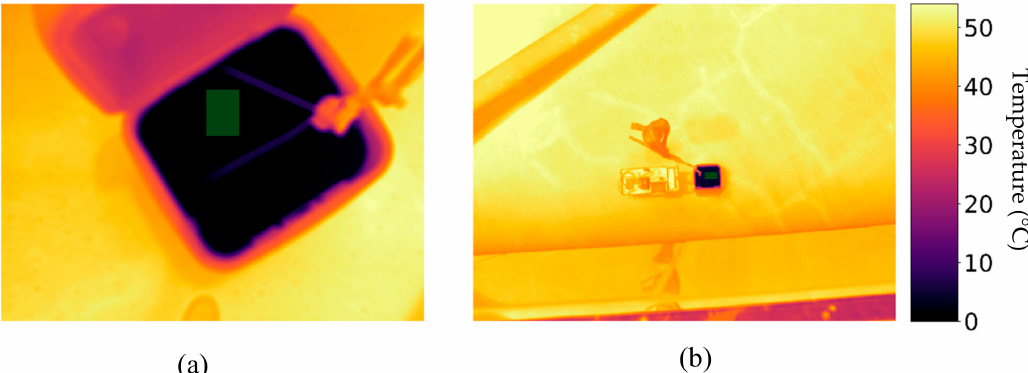
Figure 11. ( a ) Temperature map of a cooler filled with ice taken at a distance of ~40 cm with an ambient temperature of 37 ◦ C. The average value of the ice pixels inside the cooler (represented by the green rectangle) was –0.105 ◦ C. ( b ) Temperature map of same ice filled cooler taken at a distance of ~10m. The average value of ice only pixels (green rectangle) was 4.064 ◦ C illustrating that thermographies can present adjacency e ff ects. The images displayed were collected manually with a FLIR A655sc camera and subjected to the calibration matrices described in this